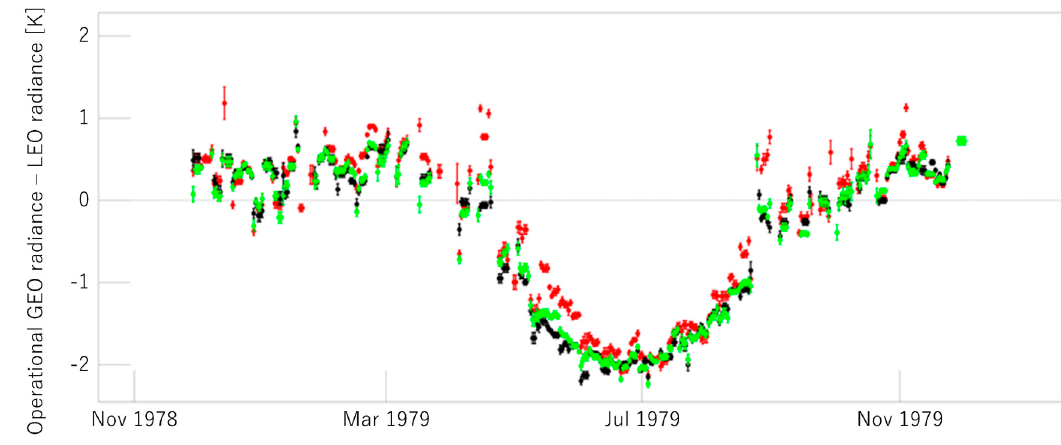
Figure 6. Time series of biases of GMS / VISSR IR channel against TIROS-N / HIRS / 2 channel 8 with different MaxStd thresholds.